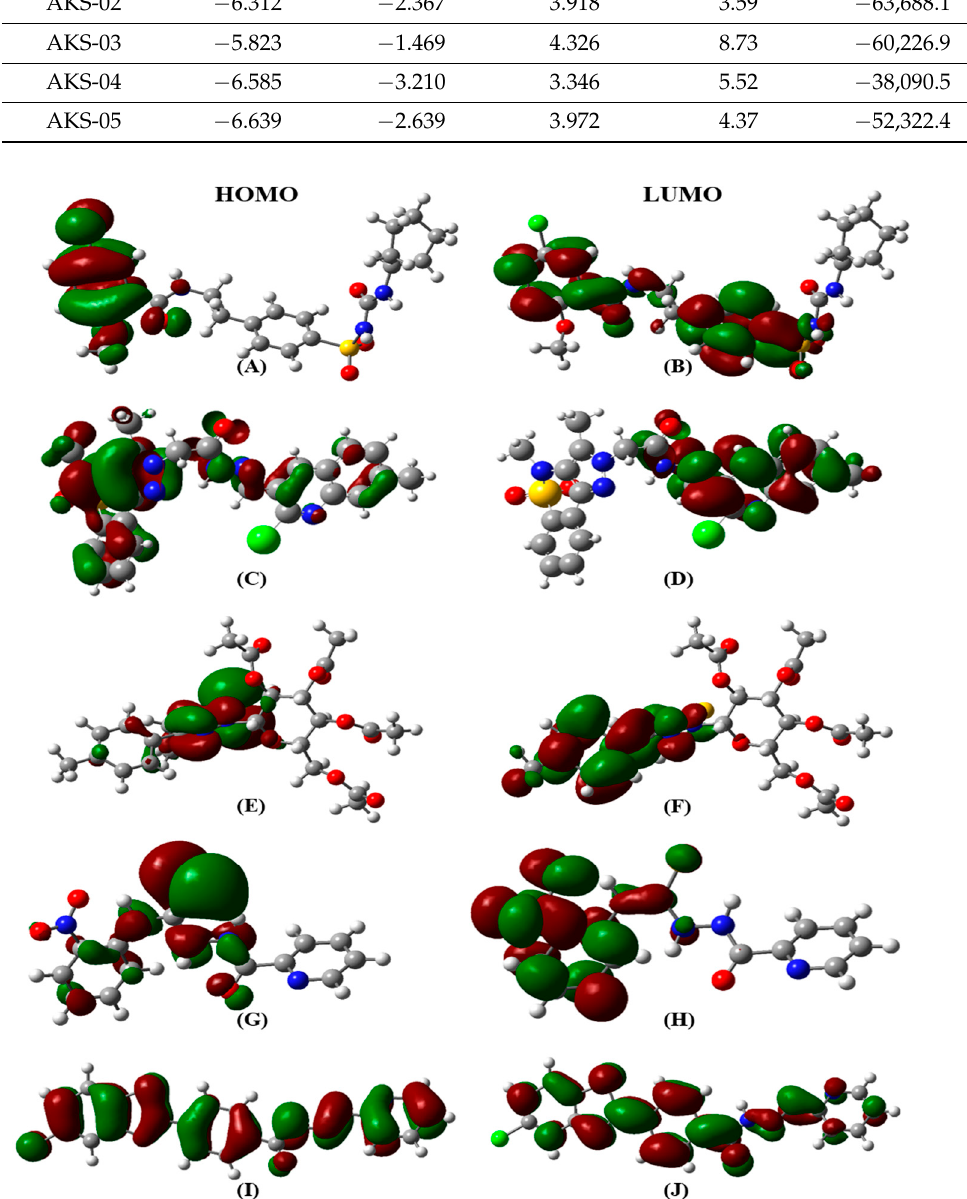
Figure 2. Spatial distribution of molecular orbitals for ( A , B ) AKS-01, ( C , D) AKS-02, ( E , F ) AKS-03, ( G , H ) AKS-04, and ( I , J ) AKS-05.